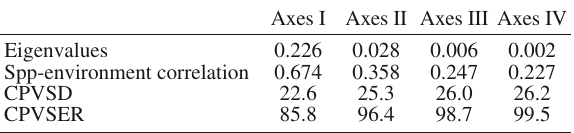
Table 6. – Summary of redundancy analysis ordination results for biological and environmental variables. Cumulative percentage